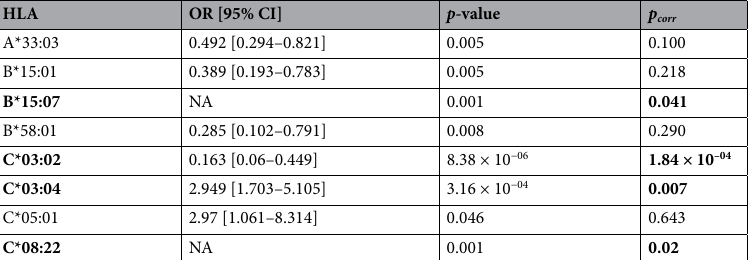
In the HLA-A locus, 21 different variants were determined by HLA genotyping (Table 1). One of these vari- ants, HLA-A*33:03, occurred more often in the controls than in the patients, showing a protective association significant on the primary level. In the HLA-B locus, 45 different variants were distinguished (Table 1), and two of them, HLA-B*15:01 and B*58:01, were associated at the primary level as protective for sarcoidosis (Table 2). Further, HLA-B*15:07 was associated as a risk variant for sarcoidosis after correction for multiple comparisons ( p corr = 0.041). In the HLA-C locus, 22 different variants were distinguished (Table 1). HLA-C*05:01 was associ- ated with sarcoidosis at a primary level as a risk variant. Protective variant HLA-C*03:02 ( p corr = 1.84 × 10 −04 ) and risk variants HLA-C*03:04 ( p corr = 0.007) and HLA-C*08:22 ( p corr = 0.02) were associated after correction for multiple comparisons (Table 2, Fig. 1). HLA-DRB1 is the HLA locus most often mentioned in connection with sarcoidosis; 41 different variants in this locus were determined by HLA genotyping in our patient group (Table 1). Variants HLA-DRB1*04:06, HLA-DRB1*13:02, HLA-DRB1*14:01 were protective and variant HLA-DRB1*14:03 acted as a risk allele for sarcoidosis, associations being significant on a primary level. After correction for multiple comparisons, alleles for sarcoidosis (Table 3, Fig. 2). Regarding the HLA-DQA1 locus, 17 variants resulted from HLA genotyping (Table 1). HLA-DQA1*05:03, HLA-DQA1*03:01, HLA-DQA1*05:01, and HLA-DQA1*01:01 were associated on the primary level as protec- tive for sarcoidosis. Variant HLA-DQA1*05:06 was associated with the risk for sarcoidosis on the primary level. After correction for multiple comparisons, HLA-DQA1*01:02 ( p corr = 3.64 × 10 −05 ) was found as protective and